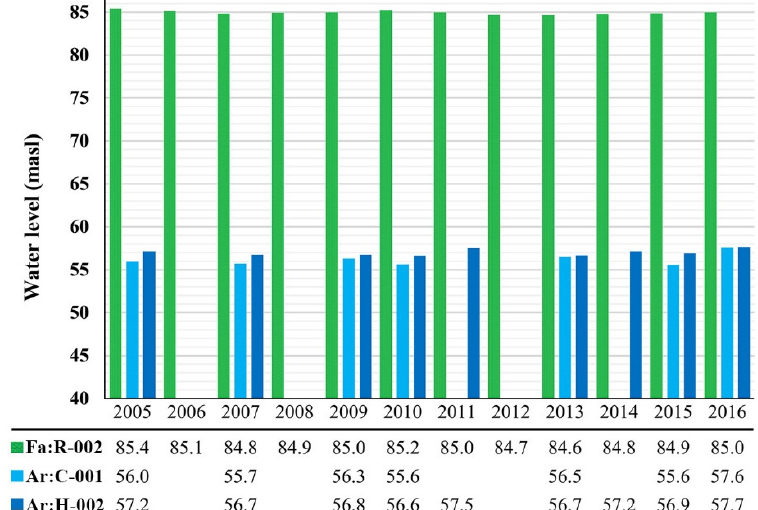
Figure 5. Average annual water level elevation in meters above sea level (masl) of the study period for monitoring wells screened in the Memphis aquifer Well Fa:R-002 near the eastern boundary and Ar:C-001 and Ar:H-002 near the southwestern boundary (See Figure 2a). Information from the USGS National Water Information System (NWIS) [71].